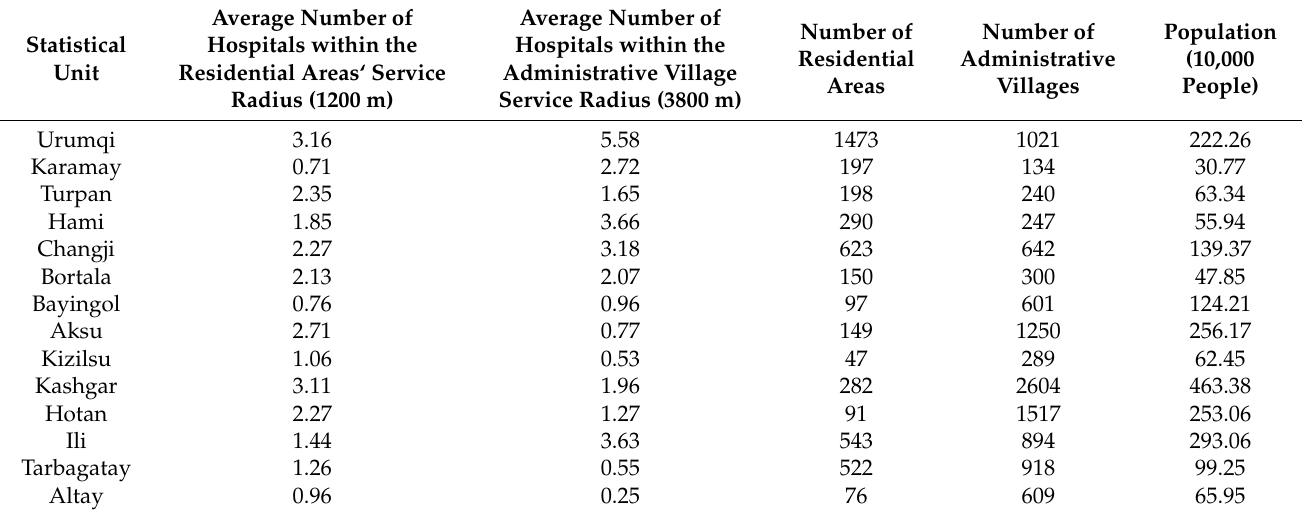
Table A3. Parameters for calculating the accessibility of medical institutions in Xinjiang.